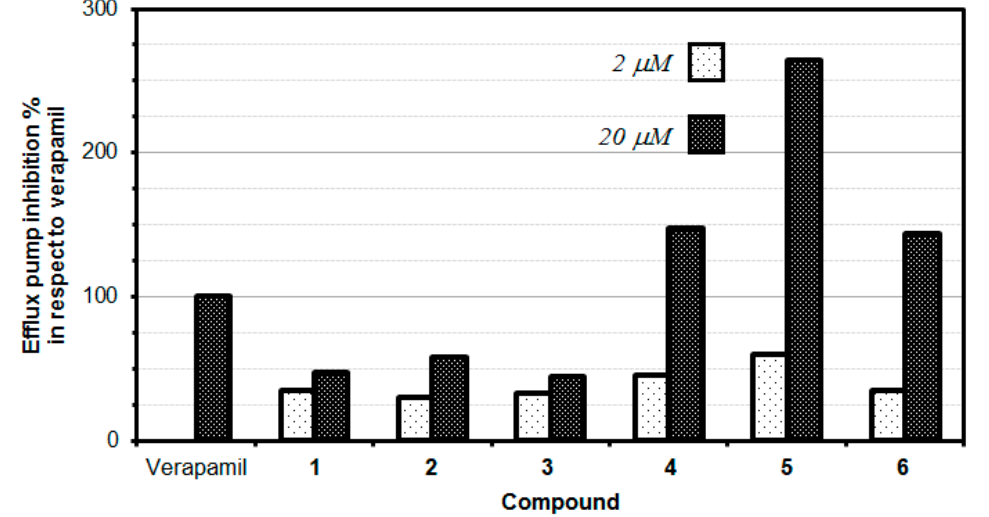
ffl ux pump inhibition of novel flavonoids and bioisosteric Figure 3. Efflux pump inhibition of novel flavonoids and bioisosteric analogues. Figure 3. E